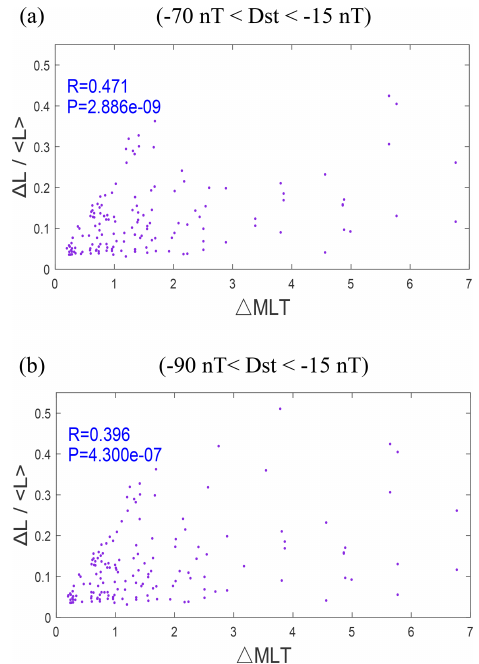
Figure 6. The relationship between (cid:49)L/ (cid:104) L (cid:105) and (cid:49)